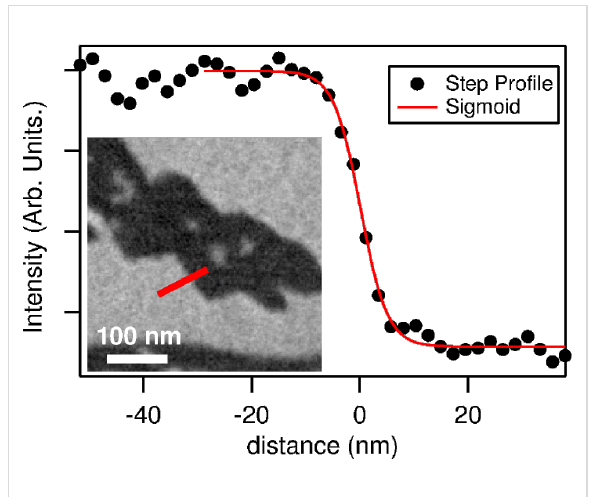
Figure 7: Lateral resolution in LEEM. The inset shows a Ni monolayer island (dark) on W(110). The profile in the plot is marked on the image. The full width of the sigmoid function is 8.2 nm. Averaging over several profiles, the value is found to be 8.6 ± 1.2